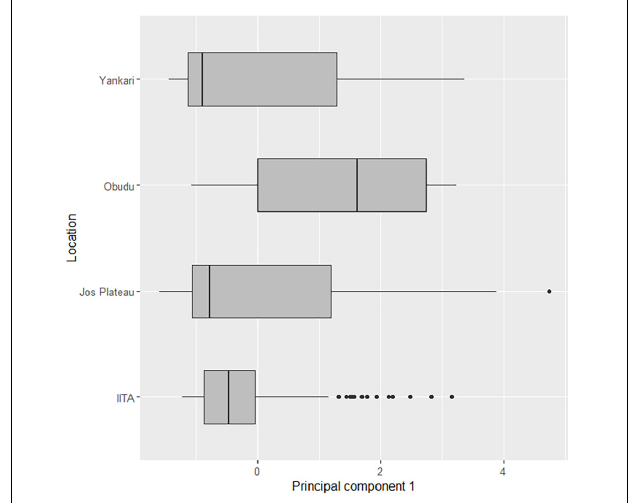
FIGURE 5 | Body size comparisons between northern and southern montane and lowland areas in